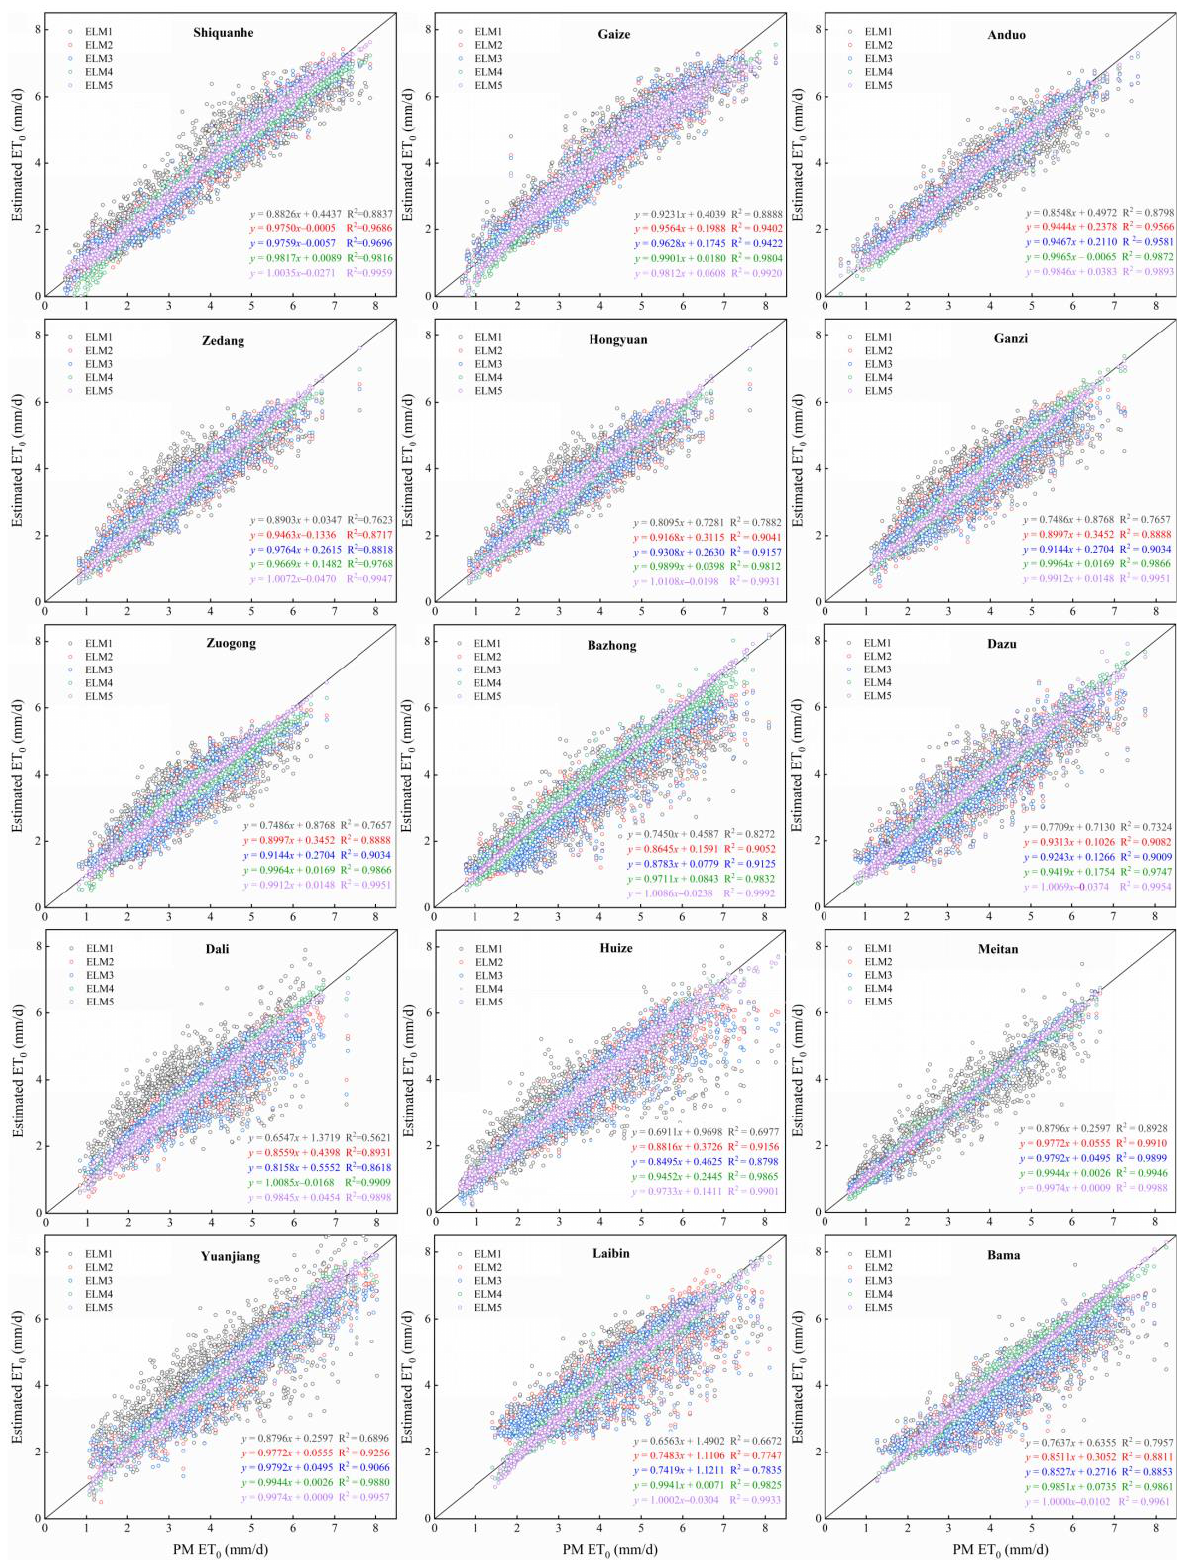
Figure 6. Scatter plots of predicted ET 0 values using ELM models against their corresponding FAO56-PM values during testing in Southwest China. (Note: the fine line represents 1:1 line).